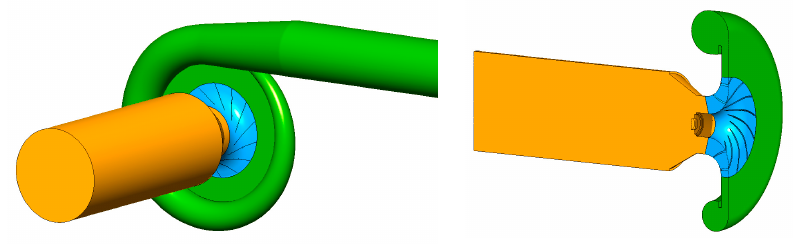
Figure 11. Geometric model of the TKR 140E compressor.